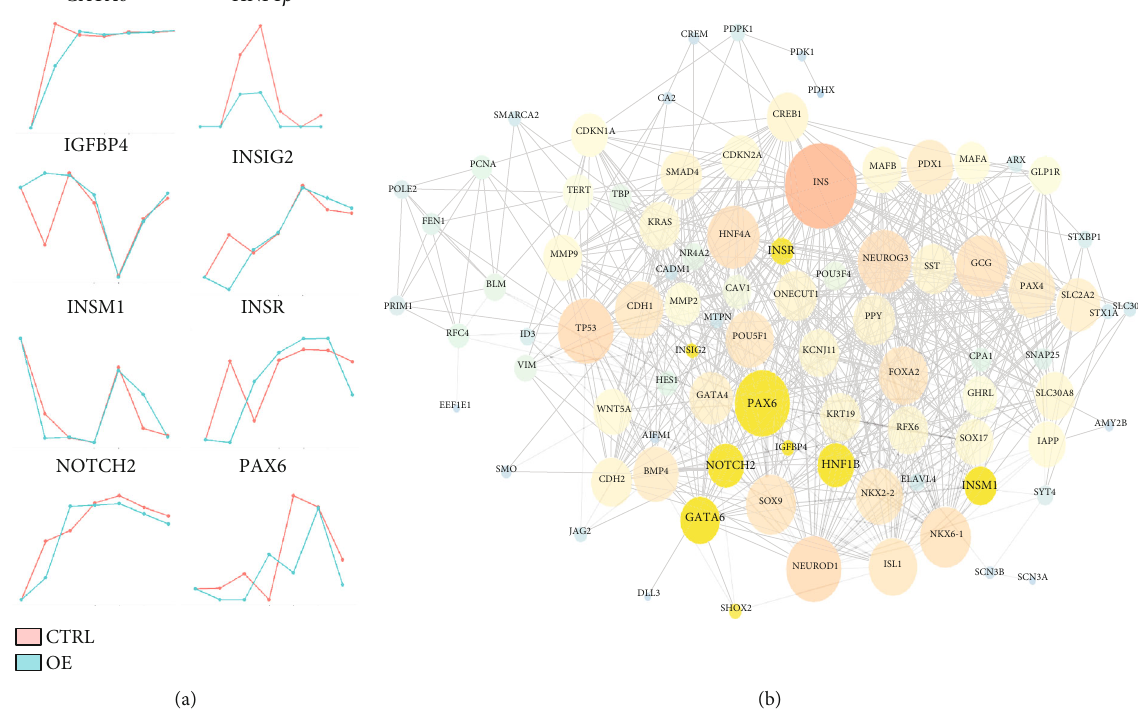
Figure 6: Overexpression of miR-375 can lead to changes in multiple signaling pathways during pancreatic development. (a) The line chart shows the expression level of some di ff erentially expressed genes occupying a central position in protein-protein interaction networks. The red line represents the control group and the green line represents the overexpression group, the abscissa represents the di ff erentiation time, and the ordinate represents the expression of the gene in di ff erent di ff erentiation stages (normalized to TPM). (b) The protein- protein interaction network obtained from the STRING database. Each circle represents a gene, and each edge represents a possible interaction between two genes. The size of the circular area represents the importance of the gene in the network. The highlighted genes (black characters on a yellow background) play an important role in the network and need to be analyzed individually and are plotted in